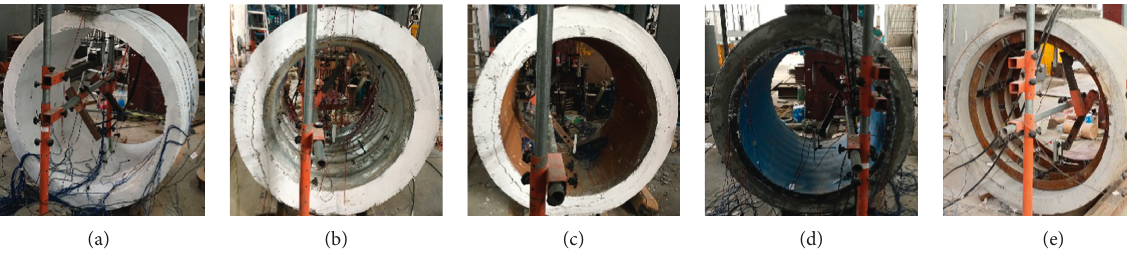
Figure 2: Specimens used in two-point loading setup: (a) RCP; (b) RGC; (c) RGS; (d) RGH; (e)